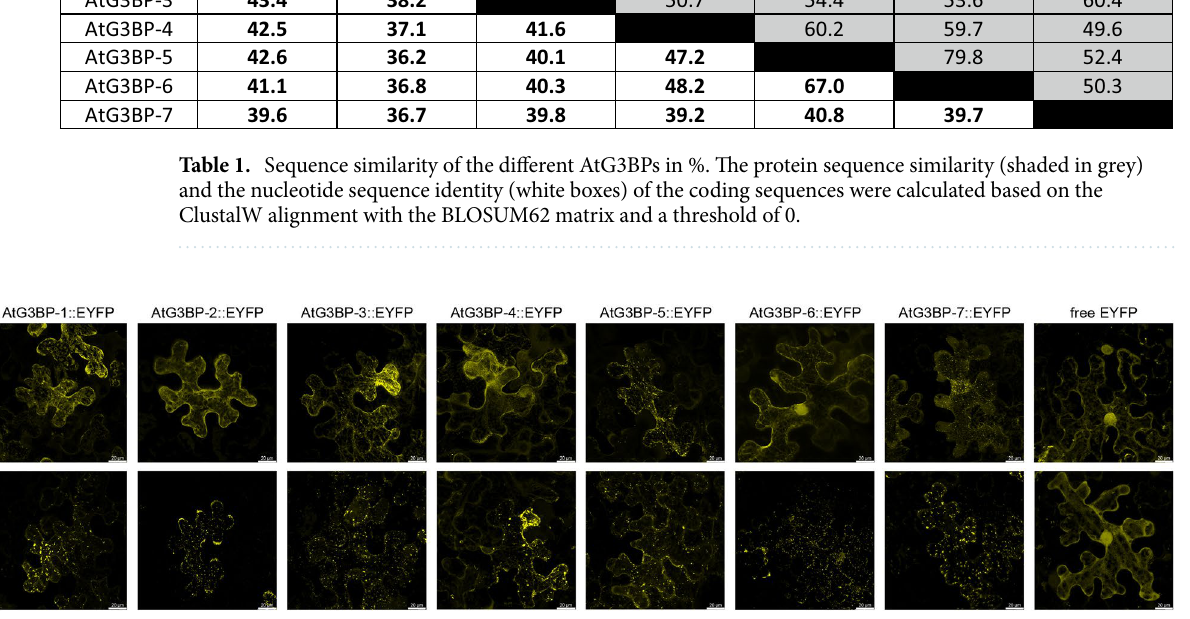
Figure 2. Subcellular localization of AtG3BP proteins and free EYFP in transient expressing N. benthamiana leaves under ambient conditions and after heat shock. Pictures are maximum projections of z-stacks obtained by confocal laser scanning microscopy and were taken 2 dpai. The individual pictures correspond to a size of 145 × 145